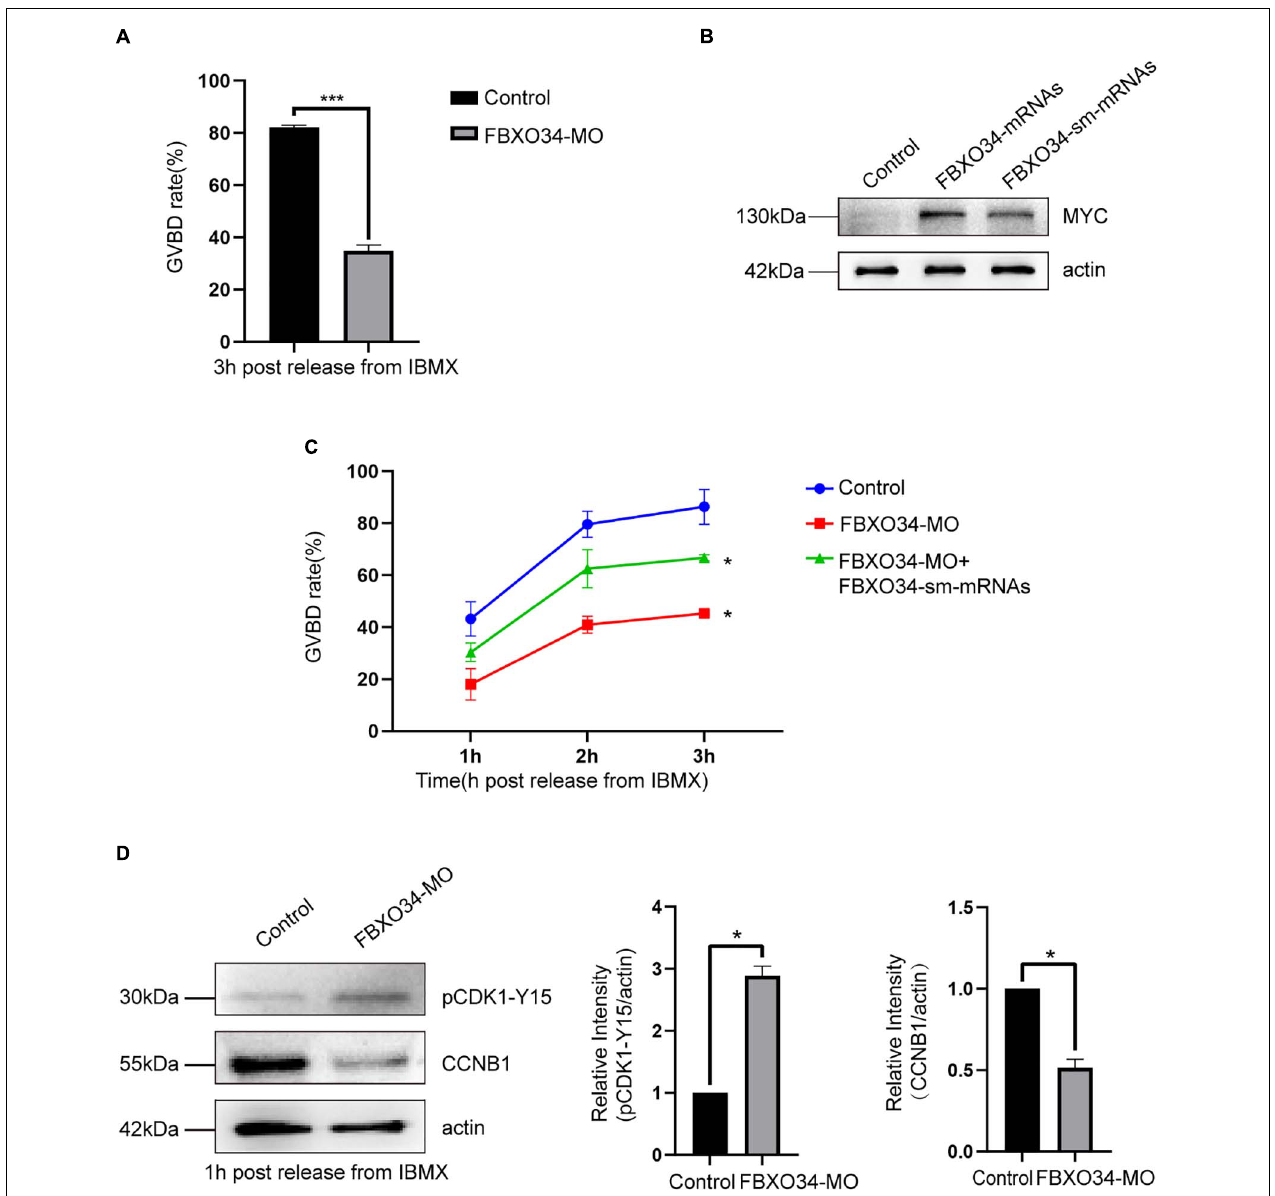
FIGURE 2 | Depletion of FBXO34 impaired the resumption of meiosis and activity of MPF. (A) GVBD rates of control group and FBXO34-MO group at 3 h following release from IBMX inhibition. (B) Western blot of FBXO34-MYC and actin in control, FBXO34 mRNA–injected, and FBXO34-sm mRNA–injected oocytes (100 oocytes per sample). The molecular weight of FBXO34-MYC is 130 kDa; the molecular weight of actin is 42 kDa. (C) After oocytes were released from IBMX inhibition, GVBD rates of oocytes at 1, 2, and 3 h for control group; FBXO34-MO group; and FBXO34-MO+FBXO34-sm mRNA group were summarized. (D) After oocytes were released from IBMX inhibition, Western blot of the phosphorylation level of Tyr15 of Cdk1 (pCdk1-Y15), CCNB1, and actin in the control group and the FBXO34-MO group were presented (180 oocytes per sample). The molecular weight of pCDK1-Y15 is 30 kDa, the molecular weight of CCNB1 is 55 kDa, and the molecular weight of actin is 42 kDa. The relative intensity of immunoreactive bands was quantified by densitometry. Quantitative data were obtained from at least three independent repeats, and one repeat of each experiment contained at least 50 oocytes. The error bars of quantitative data represent the standard deviation (* P < 0.05, *** P <